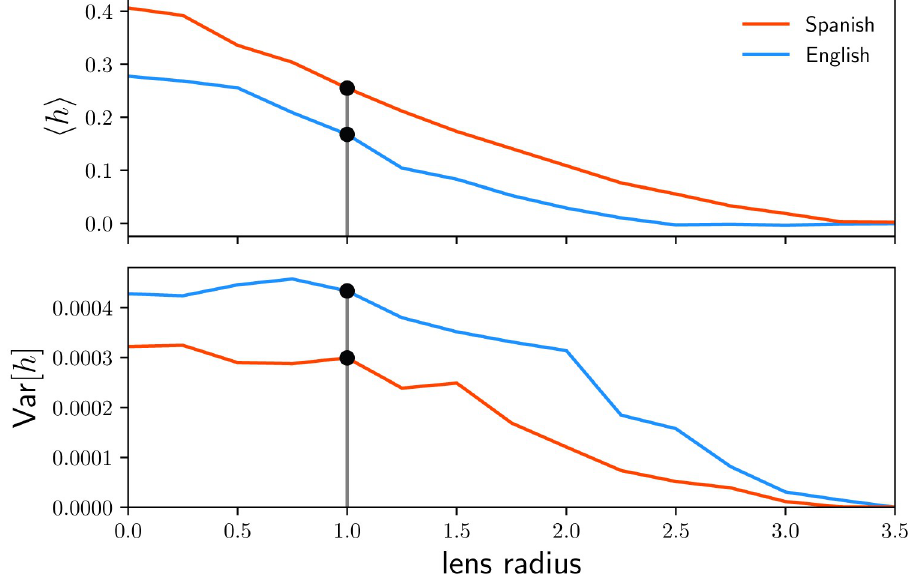
Fig 2. The mean and variance of daily sentiments at each lens radius value for English and Spanish. At all lense values, Spanish has a higher mean happiness score than English, but a smaller spread. We choose out lens size to remove a sufficient amount of neutral words, which in mass can skew the scores and make results less intuitive. A gray vertical line in each plot indicates the selected lens radius. Black dots show the values of the mean and variance of the daily sentiments at the selected lens radius. This value is selected because it is roughly the edge of the variance’s plateau for the two languages (see [26] for further support).